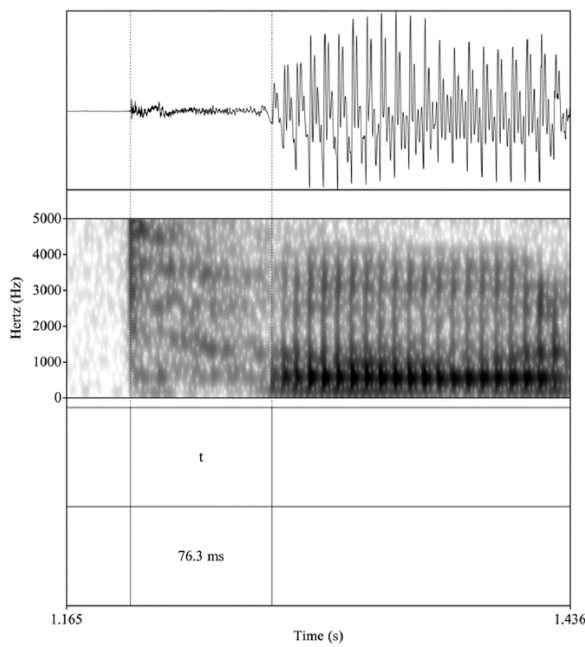
Figure 2. English production of the word-initial /t/ in total.